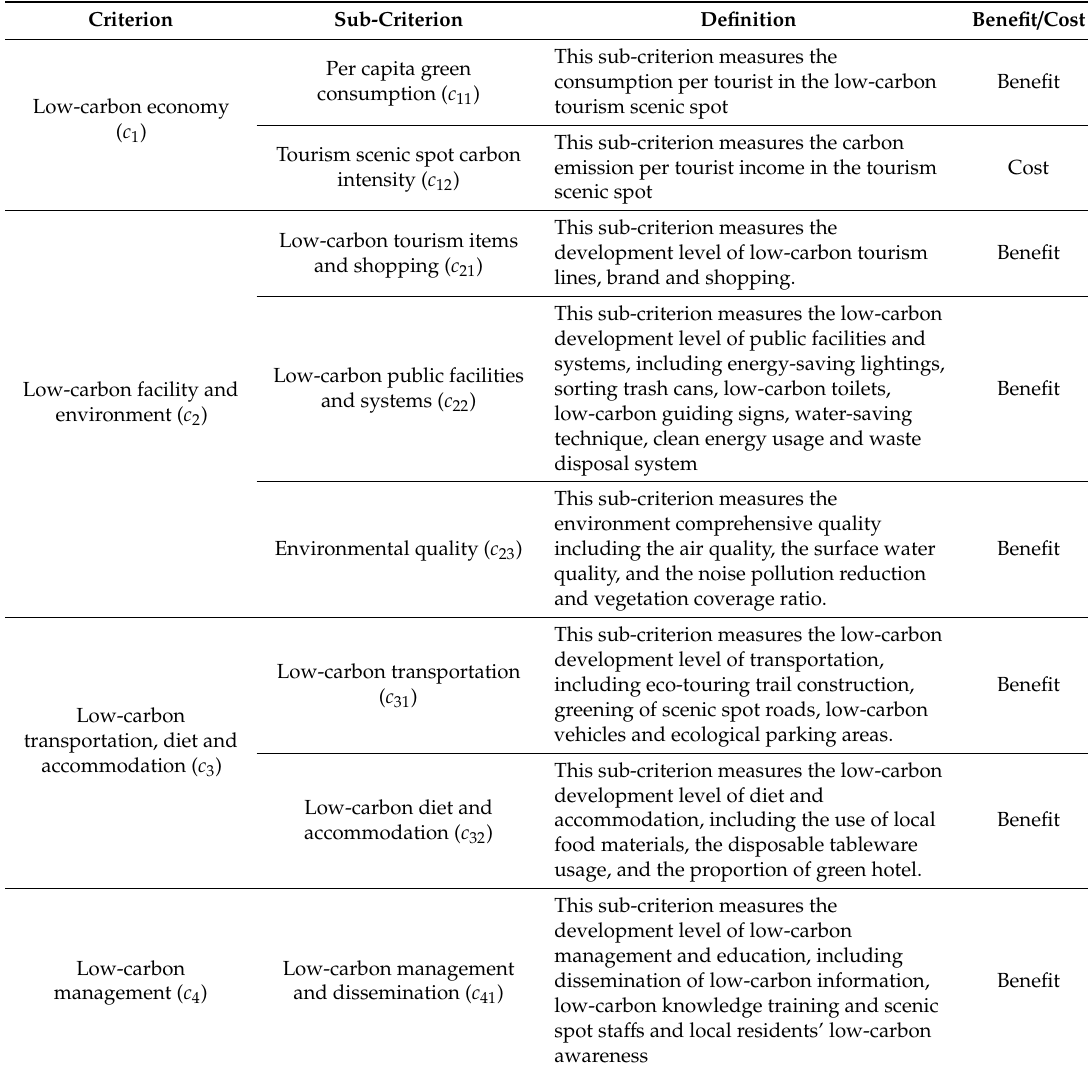
Table 2. In the eight sub-criteria, c 12 is a cost criterion and the others are benefit criteria. Table 2. The hierarchical structure of evaluation criteria and sub-criteria.